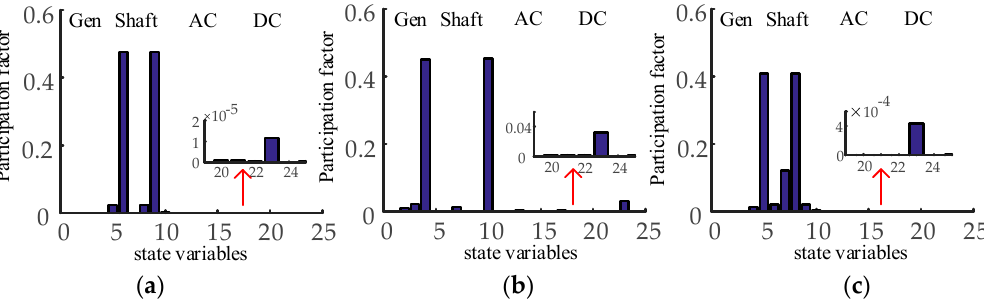
Figure 7. Participation factors of the oscillation modes associated with SSTI ( a ) Mode-1 ( b ) Mode-2 ( c ) Mode-3.